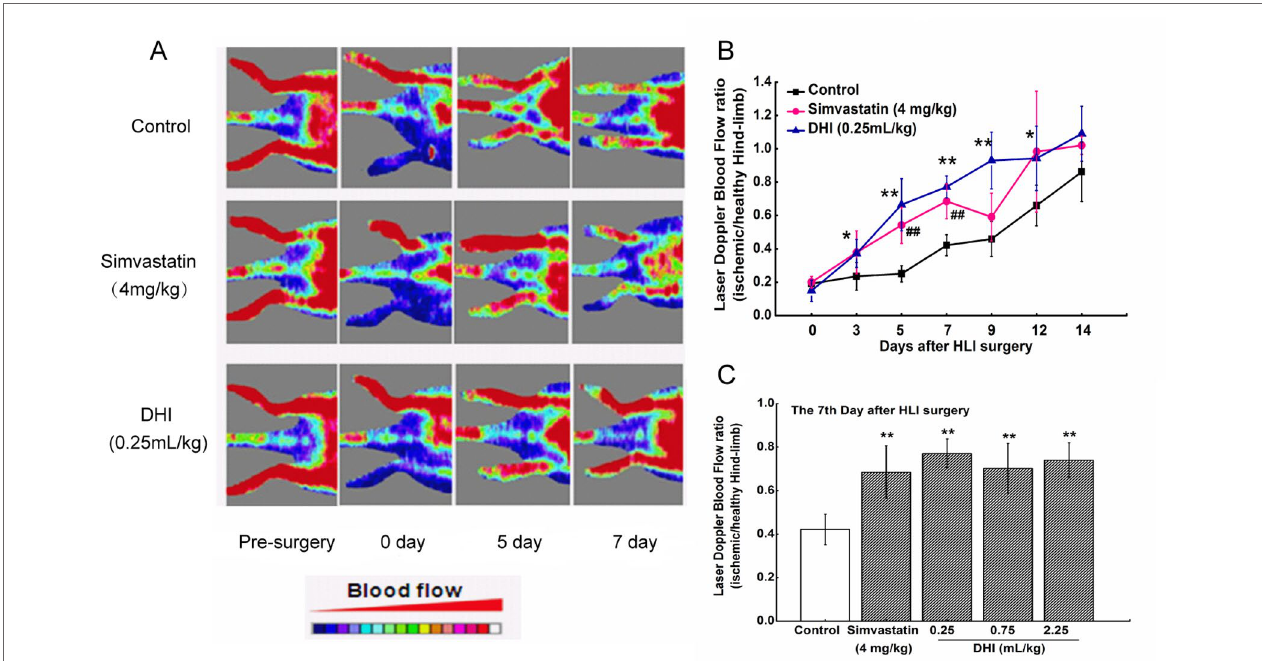
FIGURE 1 | DHI improved perfusion of ischemic limbs in ischemic rats. (A) Representative images of laser Doppler perfusion analysis for the control group, simvastatin group, and DHI (0.25 ml/kg) group before surgery and at different time points after surgery. Rats were administered with drugs for 14 consecutive days starting on the first day after surgery. Blood flow was recorded by laser Doppler flowmeter at day 0, 3, 5, 7, 9, 12, and 14 after surgery. The shift from blue to red in color indicates an increase in blood flow. (B) The mean hindlimb blood flow was calculated as the ratio of ischemic (left) side to non-ischemic (right) side. DHI (0.25 ml/kg) or simvastatin significantly improved perfusion recovery after HLI surgery. (C) All concentrations of DHI improved perfusion recovery in the ischemic rat model on the seven th day after surgery. *P < 0.05, **P < 0.01 DHI groups compared with the control group, ## P < 0.01 , simvastatin group compared with the control